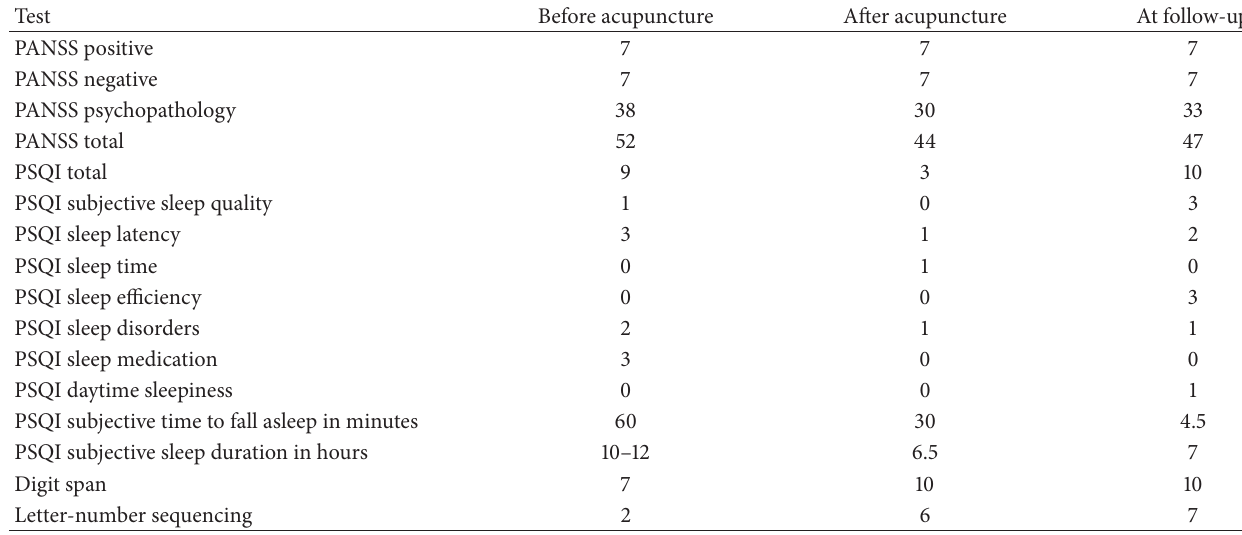
Table 1: Psychological assessmentresults for our patient with chronic schizophrenia on the PANSS, PSQI, BDI, digit span, and letter-number sequencing tests before and after acupuncture treatment and at follow-up. Test Before acupuncture After acupuncture At